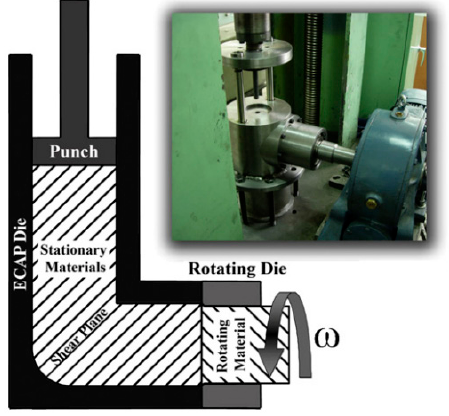
Figure 17. View of T-ECAP die [86].